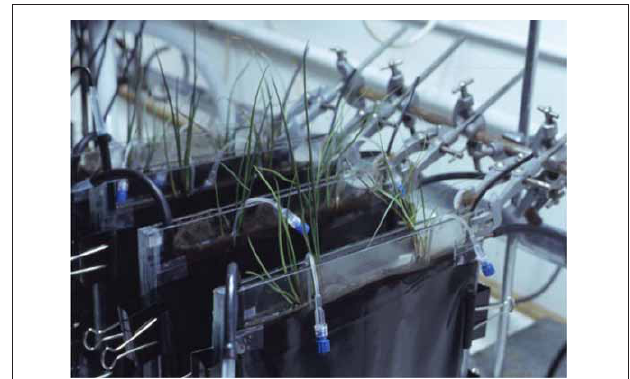
FIGURE 1 | Example of an experimental set-up using rhizotrons showing inflow, outflow, and the tubes of samplers to collect soil porewater (photo: L.